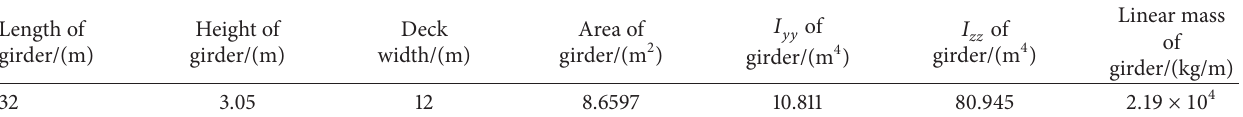
Table 6: Geometric constants of model boxinging girders.